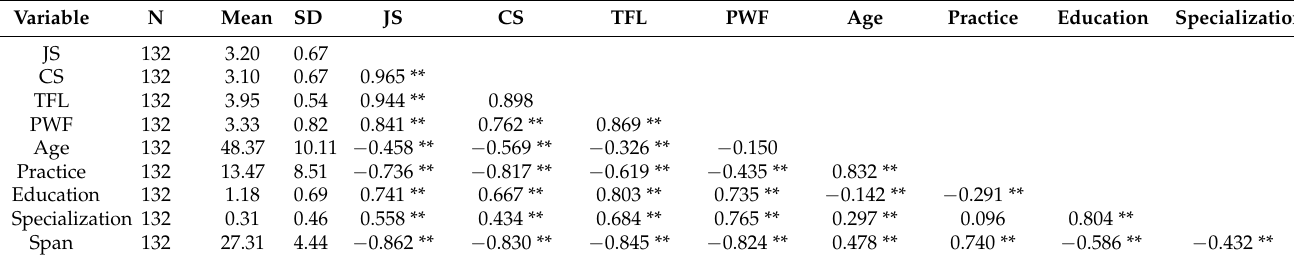
Table 1. Descriptive statistics of variables and correlation